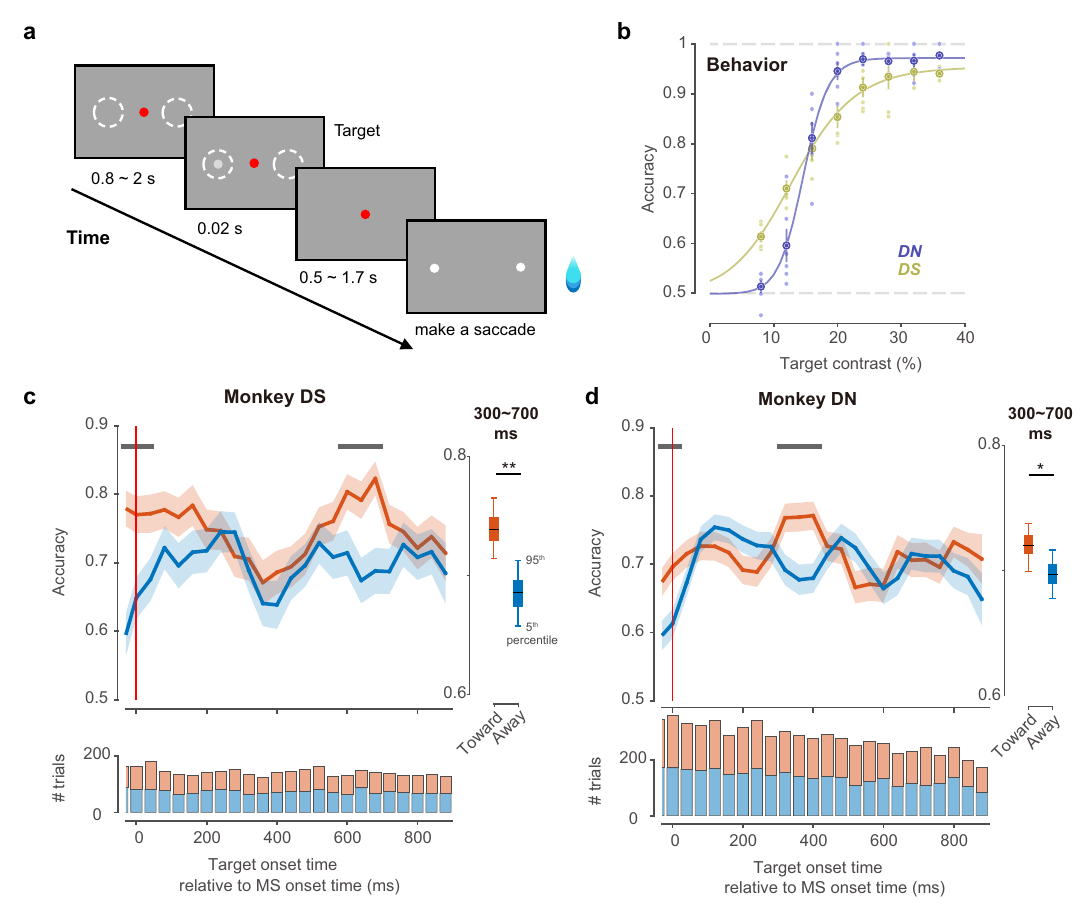
Fig. 5 | Direction modulation of microsaccades in behavioral detection tasks. a Trial procedure in a two alternative force choice (2AFC) detection task. Mon- keys fi xated on a central red dot (0.2°) for at least 0.3s to start a trial. After a variable blank period, a small (0.35°) target appeared for only 0.02s on the right side or left side (eccentricity=5°). White dashed circles indicate the potential target locations in a block, which is not visible to monkeys. Monkeys had to hold fi xation until the end of a trial. Once the fi xation point disappeared, monkeys could earn a reward by making a saccade to the target location (left white dot in the example trial). All graphic elements are not precisely scaled or luminant. In particular, the target was shown to be much smaller and weaker in luminance in the experiment. b Averaged detection accuracy (mean±s.d.) of monkey DS and DN from threshold-testing sessions ( n =6). We selected a target contrast of ~16% (target luminance= 53.13cd/m 2 , background=45.8cd/m 2 ) in formal blocks